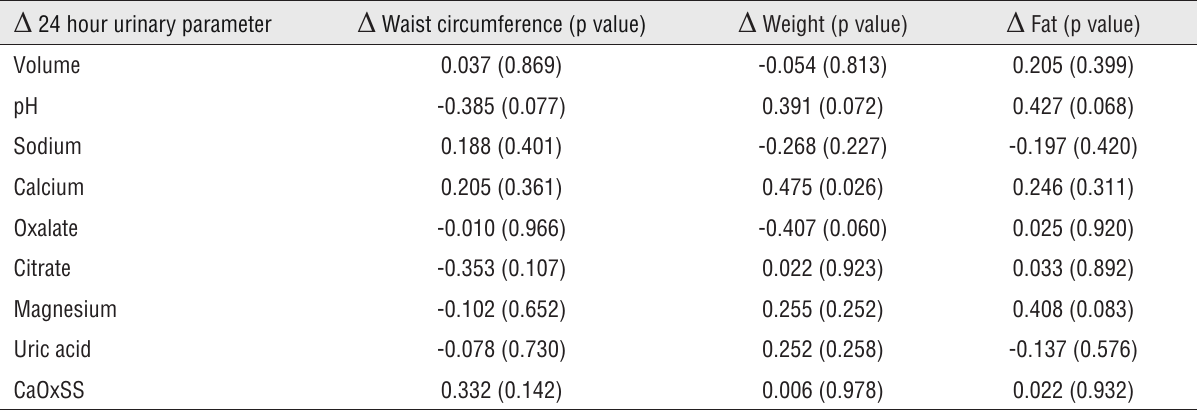
Supplementary Table 3 - Correlation between 24-hour urinary parameters change and weight change, abdominal circumference change and fat mass change in 22 patients with calcium oxalate monohydrate stones.